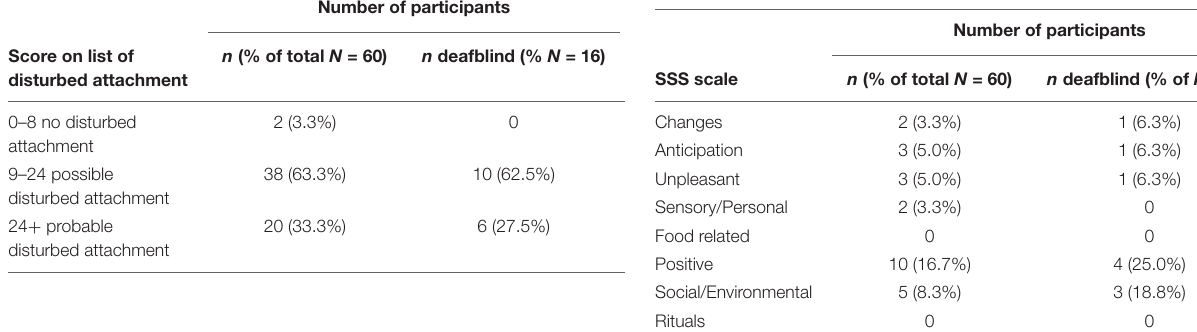
TABLE 2 | Number of participants within the clinical range of the ADAMS scale.